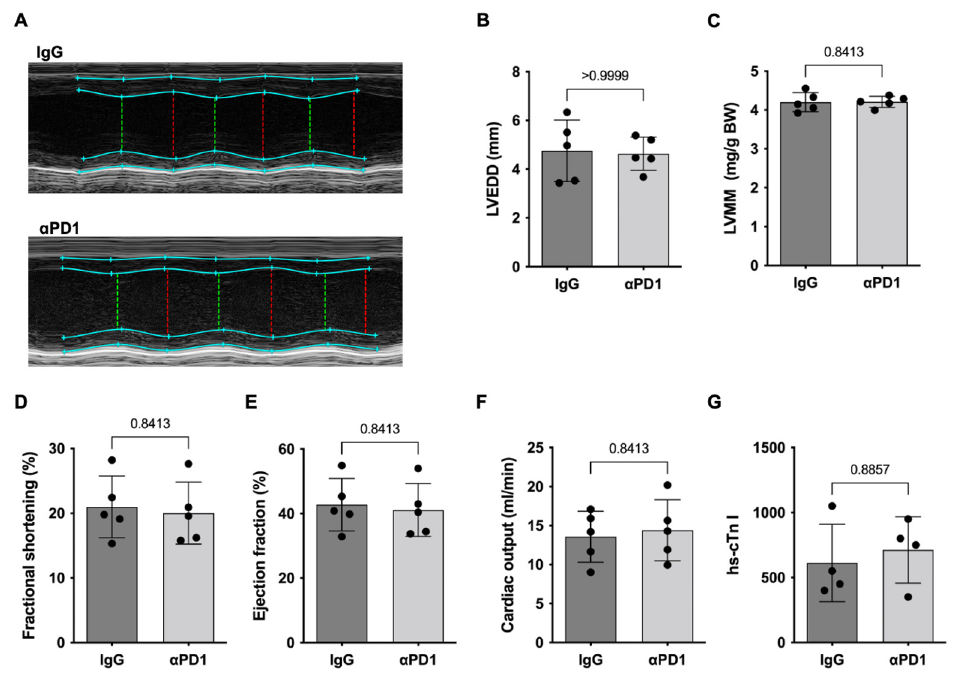
Figure 6. Cardiac function in the early phase. ( A ) Exemplary M-mode images of mouse echocardiography in mice treated with anti-PD1 antibody or IgG control followed by repAMI with 3 days reperfusion followed by quantification of ( B ) left ventricular end-diastolic diameter (LVEDD), ( C ) left ventricular muscle mass index (LVMM), ( D ) fractional shortening, ( E ) ejection fraction, and ( F ) cardiac output. ( G ) show plasma analyses of high-sensitivity cardiac troponin I ( n = 5 per group). Black dots indicate individual samples.